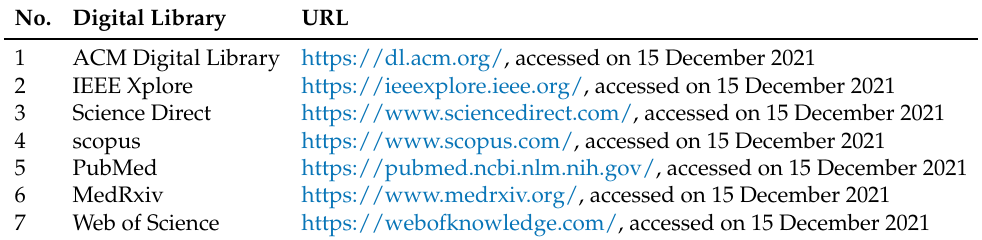
Table 1. The digital libraries used for finding articles in this